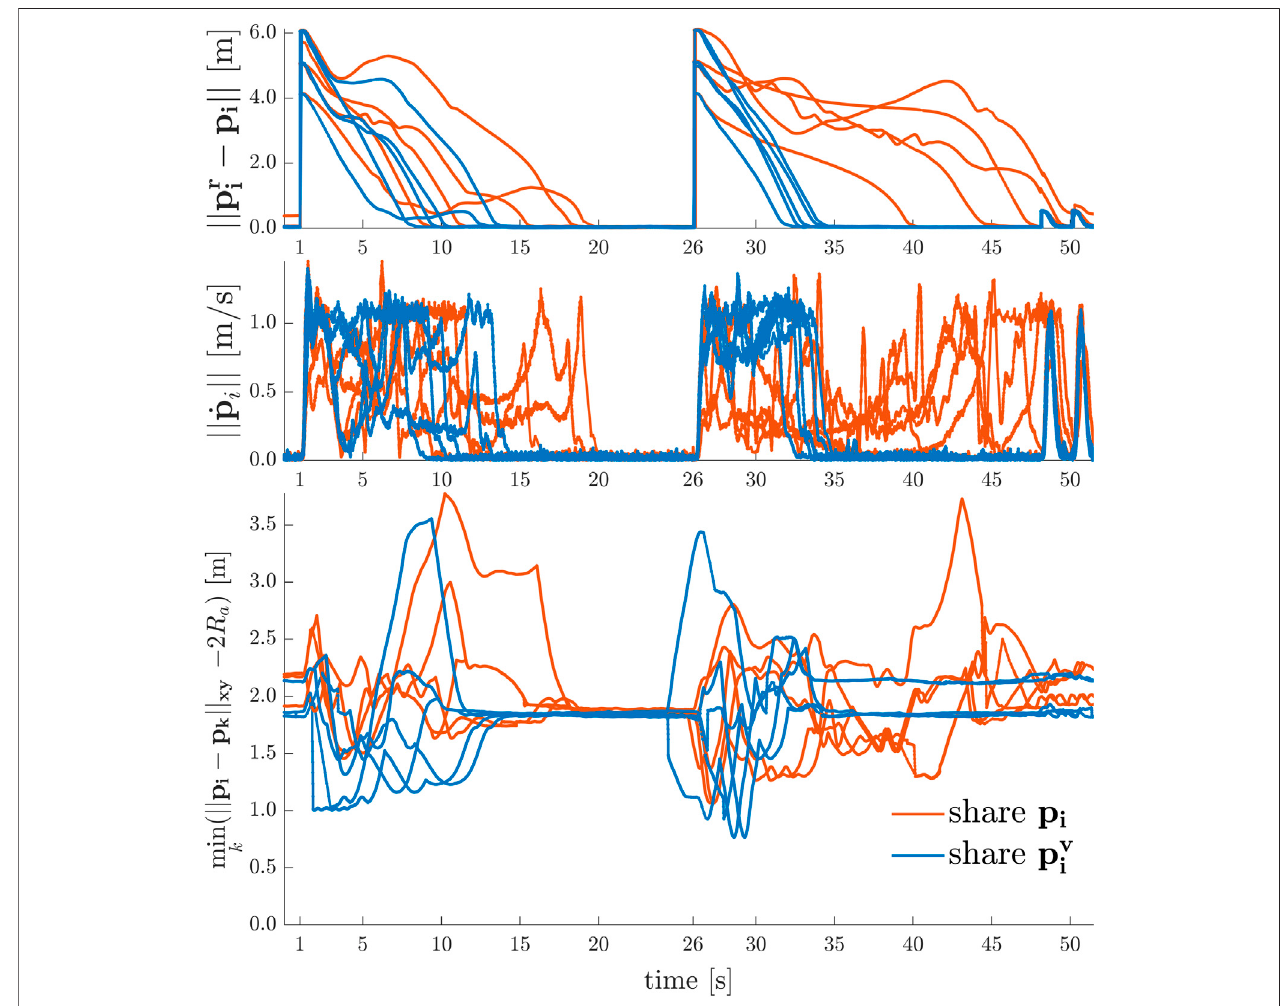
FIGURE12| 2DPoint-to-PointTransitionswithAgentCollisionandDeadlockAvoidance − Exchangingtheappliedreferenceposition p v i ( t ) overtheactualposition p ( t ) leads to a denser swarm, less distance traveled, and smaller settling times. i